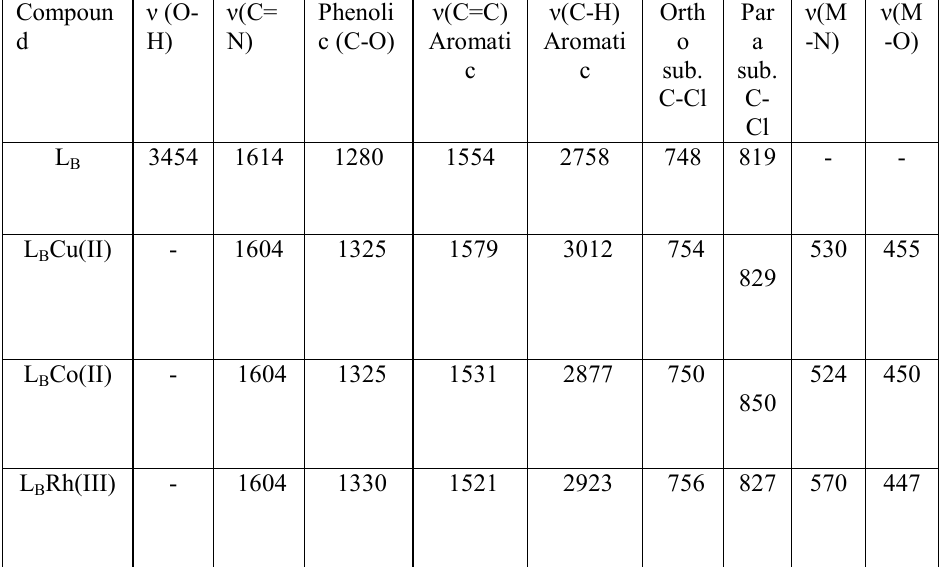
Table 2. The most significant IR bands of [L